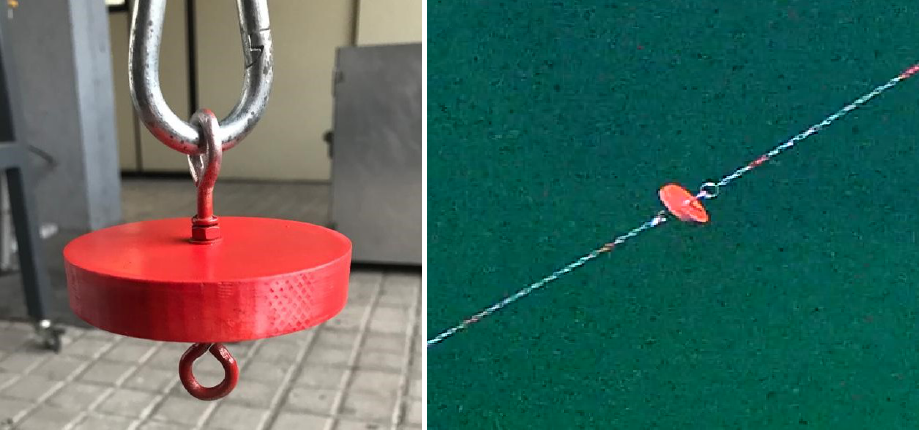
Figure 4. Designed and manufactured scaled clumped weight ( left ) and snapshot of the clumped weight installed in the mooring line obtained with the submerged camera ( right